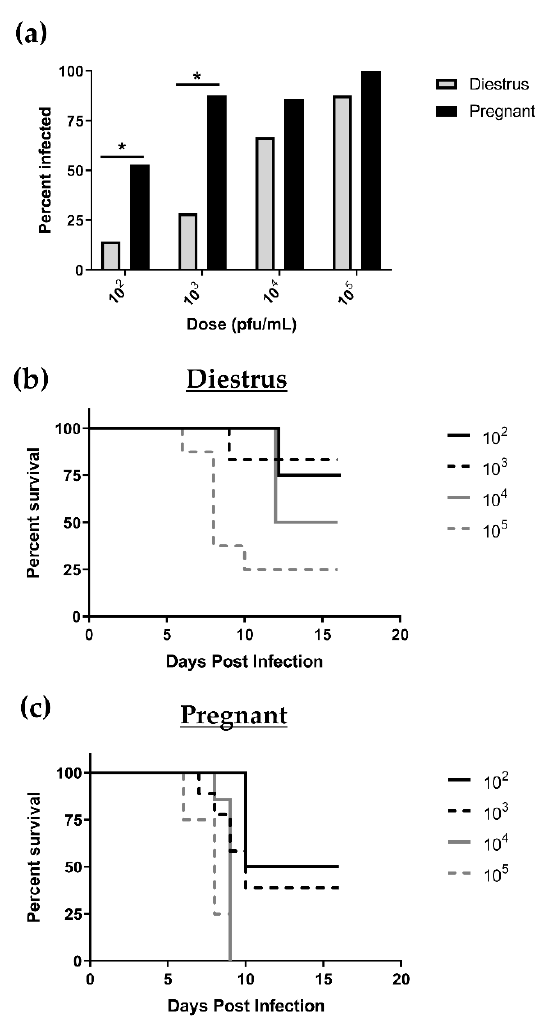
Figure 1. Pregnant mice are more susceptible to intravaginal HSV-2 infection than nonpregnant, diestrus-staged controls. ( a ) Following intravaginal inoculation with varying doses of HSV-2, pro- ductive infection was established in pregnant mice at greater rates than diestrus-staged controls, particularly at low viral doses of 10 2 and 10 3 pfu/mL. ( b ) Nonpregnant, diestrus-staged mice infected with HSV-2 were able to survive up to 16 days post infection (dpi). ( c ) HSV-2-infected, pregnant mice had decreased survival compared to diestrus-staged controls with 100% mortality observed by 9 dpi with high viral doses (10 4 and 10 5 pfu/mL). * p <